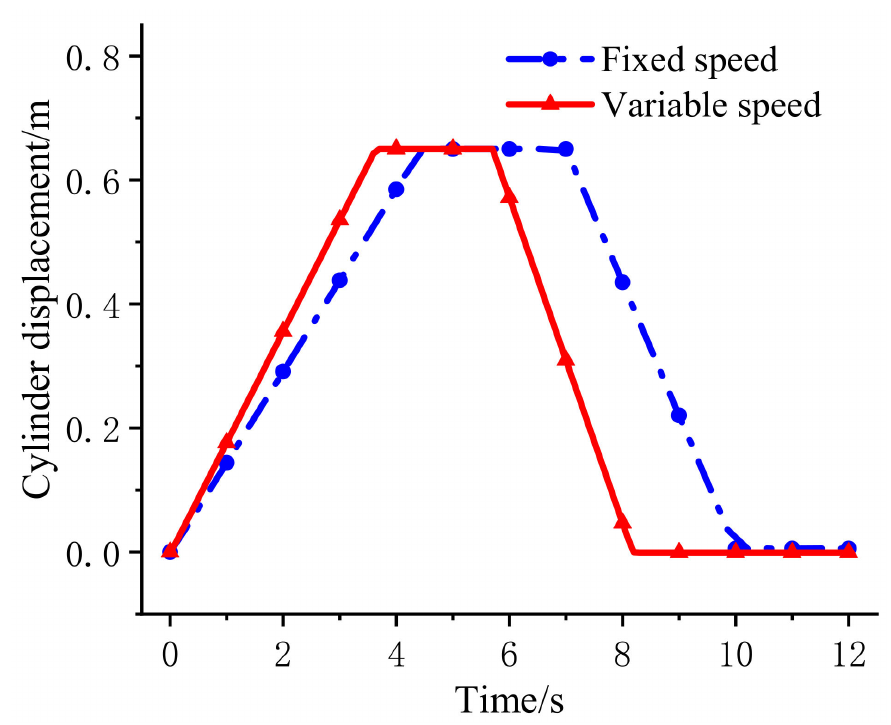
Figure 13. The displacement curve of the oil cylinder in the fixed and variable speed system.